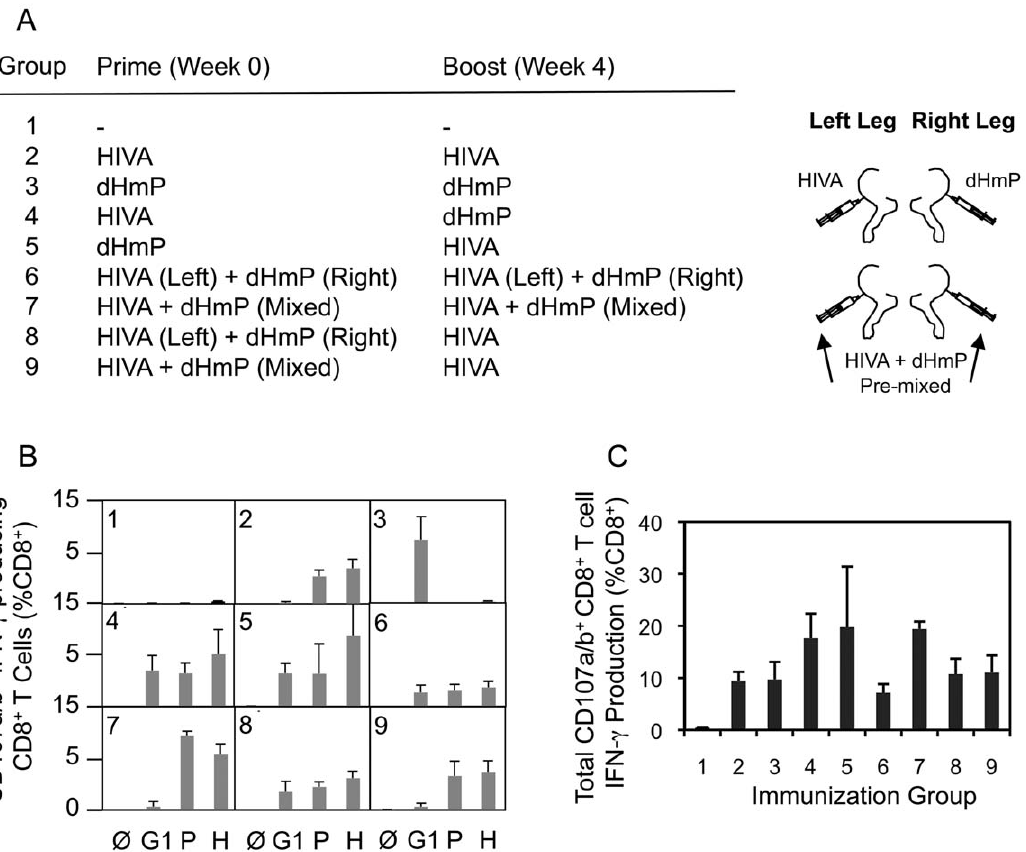
Figure 4. Physical separation of subdominant and dominant epitopes induces broad CD8 + T cell responses. A) Groups of 5 BALB/c mice were given 2x a total of 100 m g DNA at 4-wk intervals as indicated in with the HIVA or HIVAdH vaccines being given either mixed or separately into the muscles of the left and right hind legs. After a 23-wk rest, the mice were briefly re-stimulated with recombinant vaccinia virus WR.HIVA delivered i.p. and their H-, P- and G1-specific responses were analyzed using a multicolour flow cytometry 4 d later. B) Graphs show IFN- c -producing CD8 + CD107a/b + cell frequencies following an in vitro peptide re-stimulation indicated below. C) The graph gives the total IFN- c production by CD8 + CD107a/b + cells summing frequencies of G1-, P- and H-specific CD8 + CD107a/b + cells. Results in B and C are shown as mean 6 SD. One out of at two independent experiments is shown.